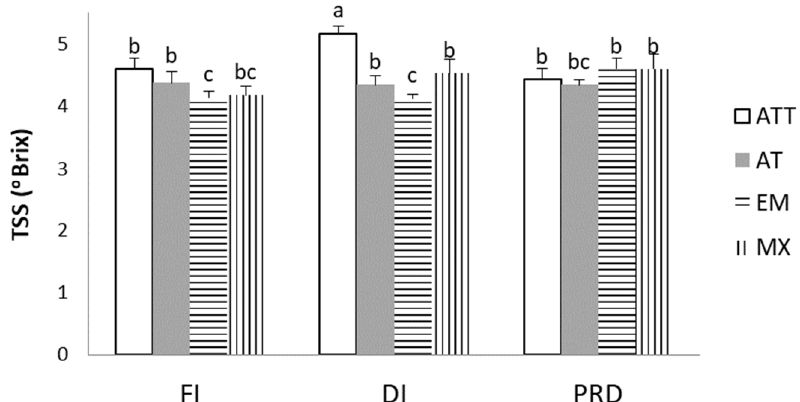
Figure 3. Total soluble solids (TSS) of tomato fruits sampled from different grafted plants grown with three irrigation techniques. Vertical bars represent SE values ( n = 4). Different letters above column indicate a significant difference by the LSD test at p ≤ 0.05. ATT—one-stem Attiya; AT—two-stem Attiya; EM—Emperador; MX—Maxifort.